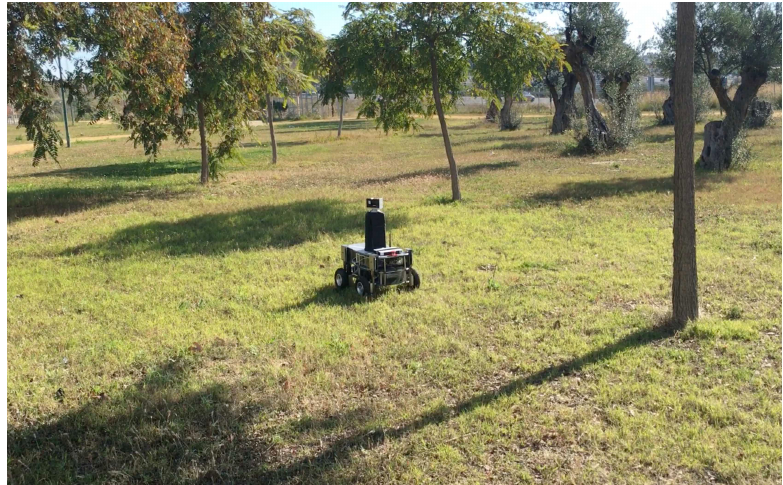
Figure 8. Andabata navigating on an urban